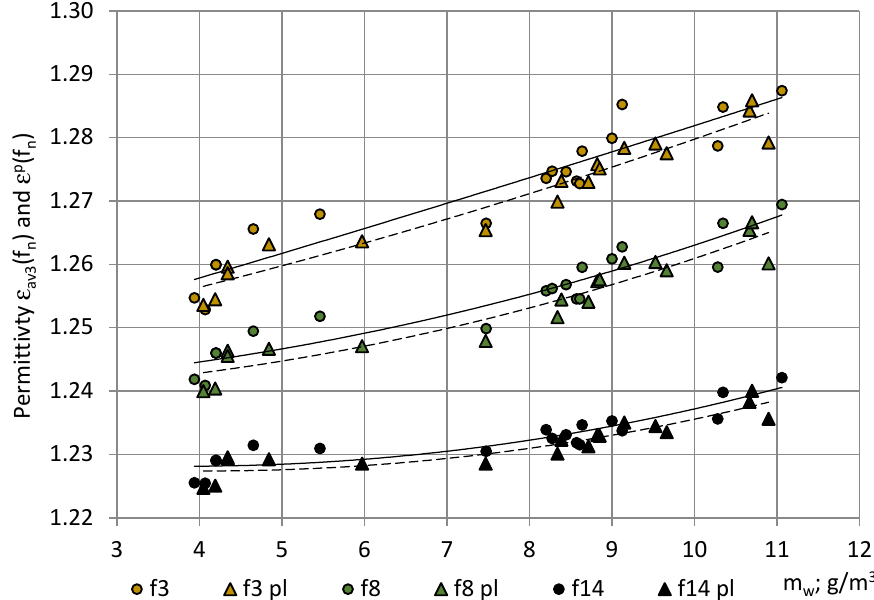
Figure 12. The dependence of permittivity of PU SikaBlock ® -M150 foams (density of 144 kg/m 3 ) in the long series on water vapor mass m w in the air of the test room at frequencies f 3 = 40 Hz (beige), f 8 = 1280 Hz (green), and f 14 = 81 920 Hz (black). (1) Bullets—average permittivity of the first three measurements ε av3 (f n ) and (2) triangles—the plateau values ε p (f n